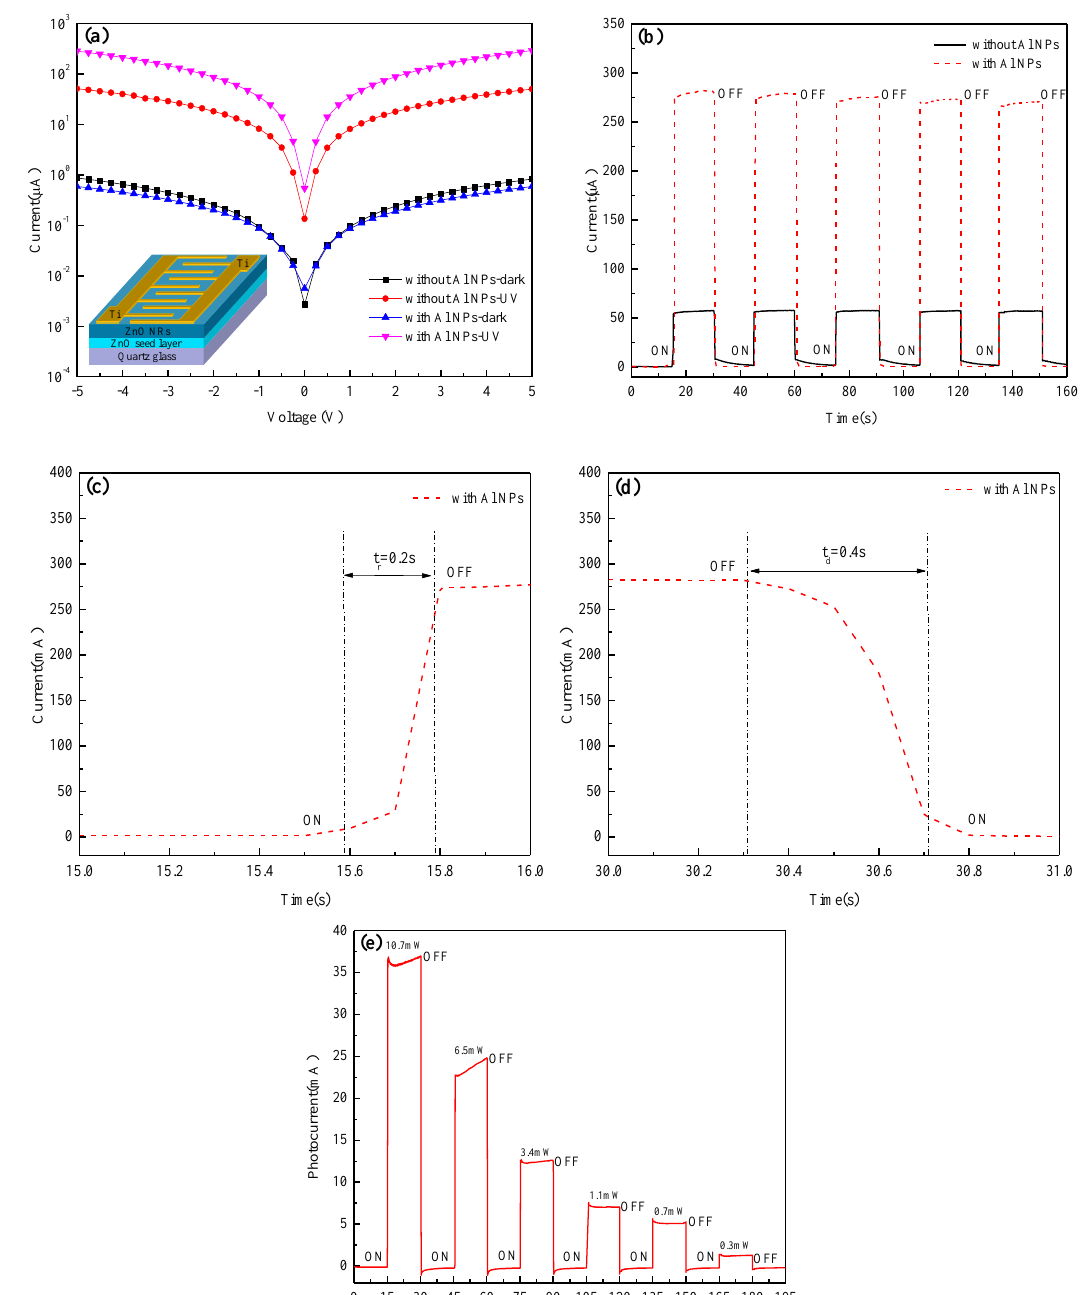
Figure 4. I − V characteristics of the photodetector of ZnO NRs ( a ), time-dependent photoresponse of ZnO NRs ( b ), enlarged rising and ( c ) decaying edges ( d ) of the transient photoresponse of ZnO NRs measured by pulse UV irradiation, and I − V characteristics of ZnO NRs decorated with Al NPs under different UV radiant intensities ( e ).